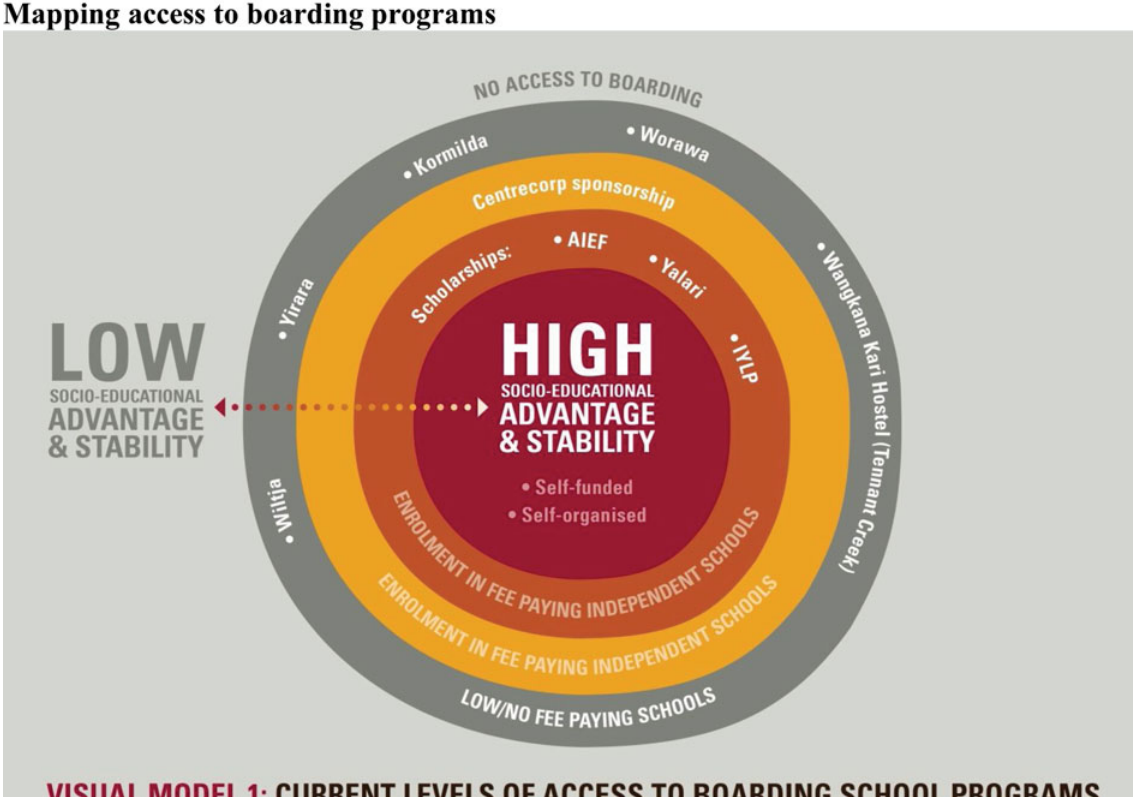
(Colour online) Visual model 1 depicting access to boarding school